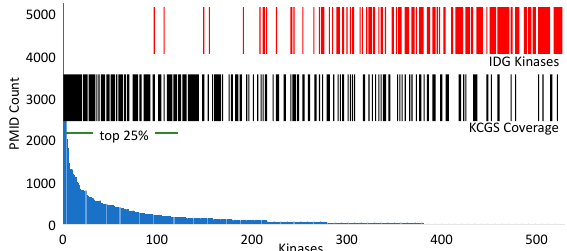
Figure 1. Analysis of kinase coverage in KCGS by publication frequency. The blue histogram indicates the number of publications for each kinase in PubMed (Table S2) [24,25] ordered by frequency with the top 25% noted by the horizontal bar. The red vertical bars indicate the 162 poorly studied dark kinases nominated by the NIH Illuminating the Druggable Genome (IDG) initiative [7]. The black vertical bars indicate the 215 kinases covered by an inhibitor in KCGS version 1. 2.3. Chemotype Analysis To aid analysis of screening data and to support future expansion of KCGS, a method was developed to assign each inhibitor to a specific chemotype based on the chemical structure of its hinge-binding moiety. To accomplish this, 119 known kinase hinge-binder substructures were defined manually and codified using SMILES (Simplified Molecular Input Line Entry System) arbitrary target specification (SMARTS) [26]. To resolve issues where an inhibitor could be assigned to multiple bins, SMARTS were given a priority or-